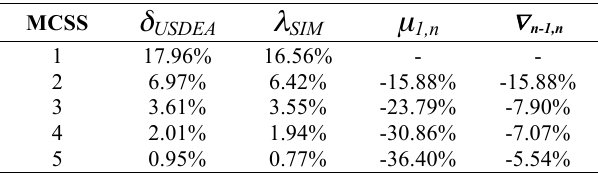
Table 6. Effect of Increasing MCSS, Communications